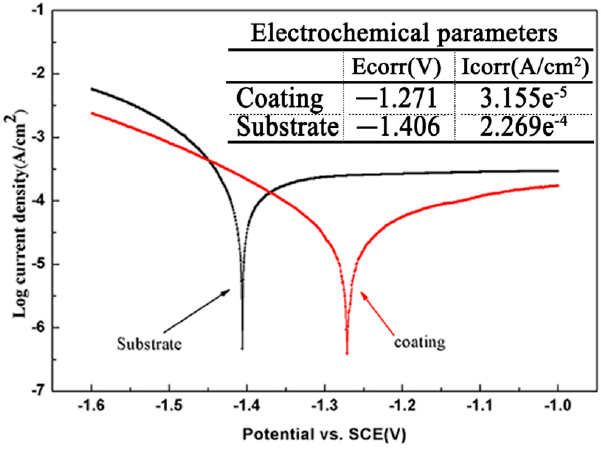
Figure 12. Potentiodynamic polarization curves for the 7075 aluminum substrate and coating.